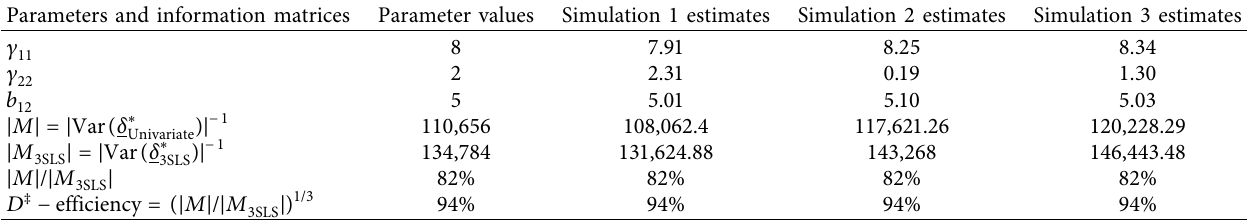
Table 3: Parameter values, estimates, determinants of information matrices, their ratios, and D -efficiency based on a 3SLS D -optimal design and a univariate optimal design for three simulations.